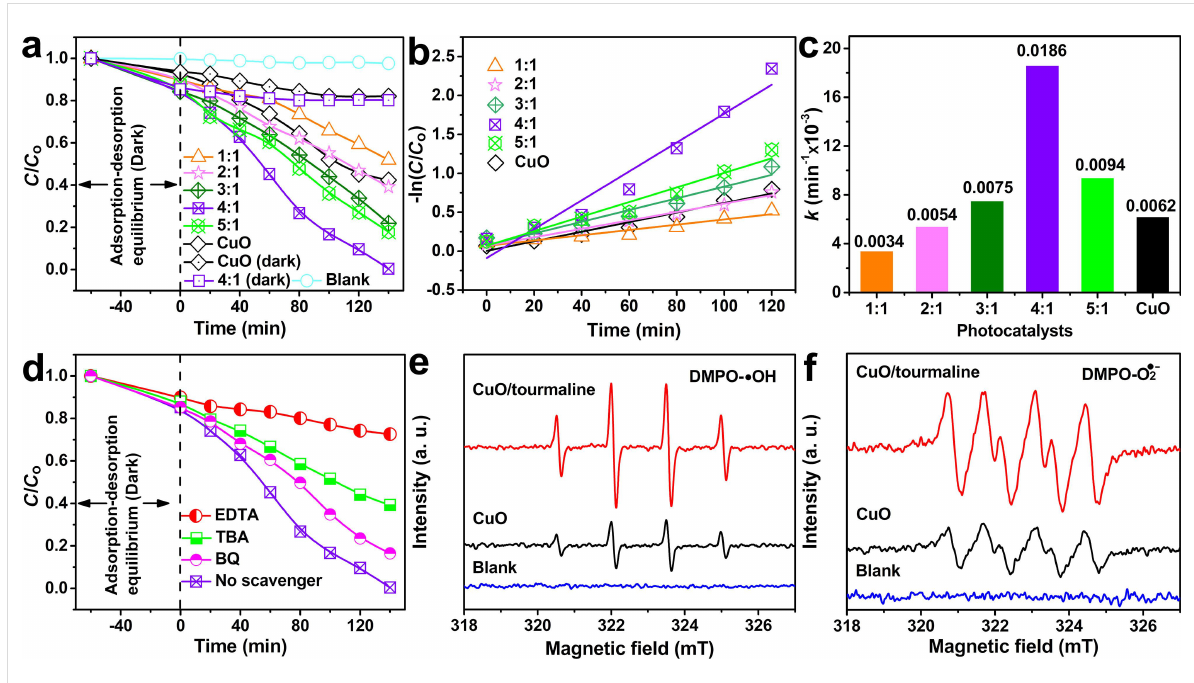
Figure 6: (a) MB degradation, (b) the apparent pseudo-first-order kinetic plots, and (c) rate constant k of the CuO/tourmaline composite in different mass ratios of the CuO/tourmaline. (d) MB degradation over the CuO/tourmaline-4:1 composite with different reactive species scavengers. Experi- mental conditions: [MB] 0 = 0.01 g L − 1 , [photocatalyst] 0 = 0.5 g L − 1 , volume = 100 mL, temperature = 25 °C. EPR signals of (e) DMPO-•OH and (f) DMPO-O 2 • − adducts of the CuO and CuO/tourmaline composite under visible-light irradiation.